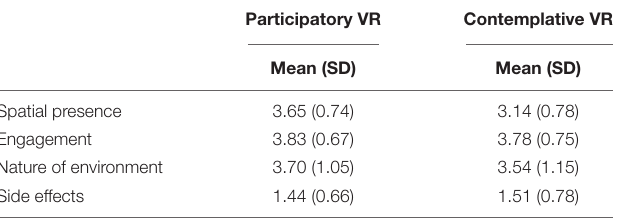
TABLE 2 | Means and standard deviation of the sense of presence by presence factor according to the condition.